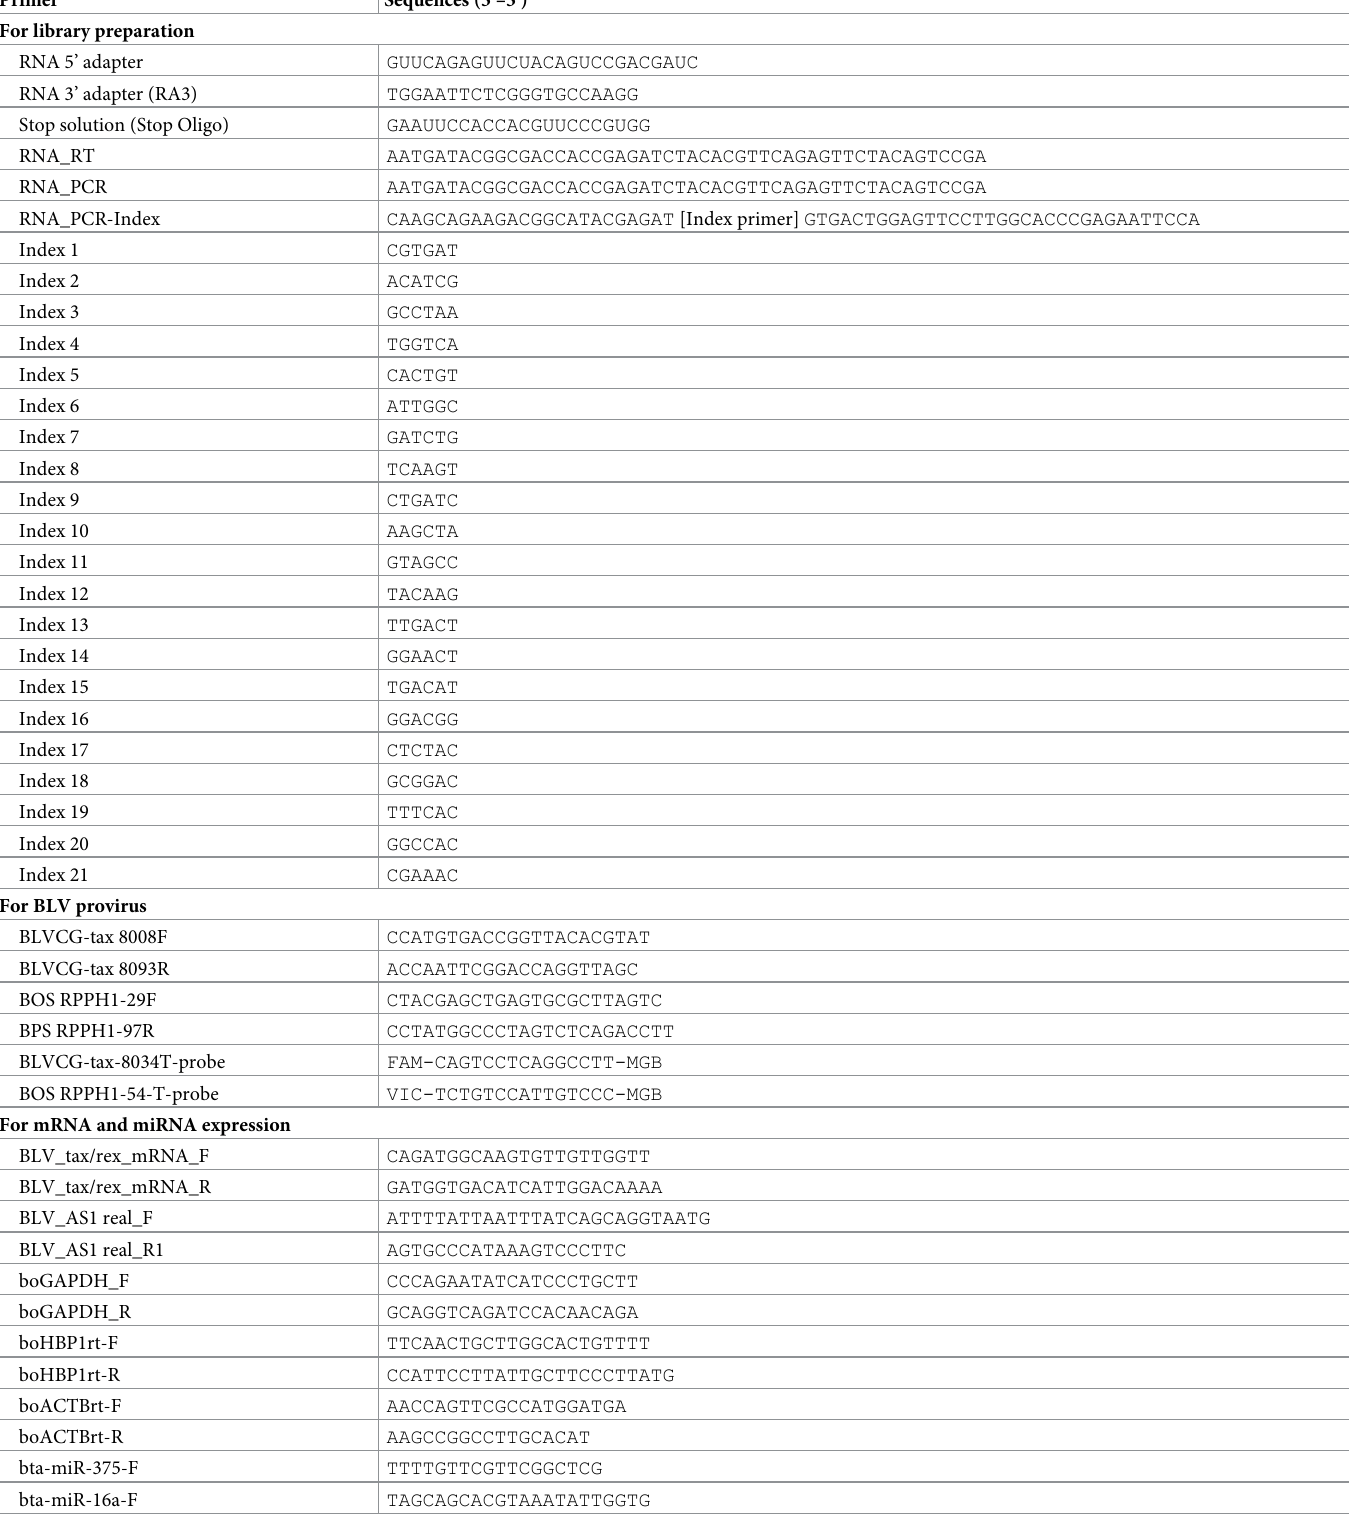
Table 2. Primers and probes for library preparation and quantitation of BLV provirus, mRNA, and miRNA expression.